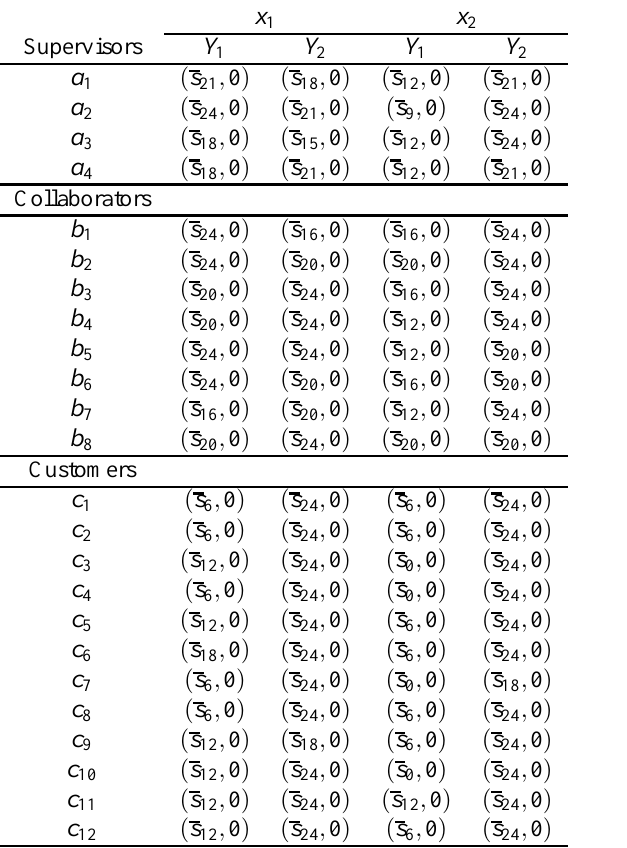
Table 4. Unified assessments for each collective and each crite- rion